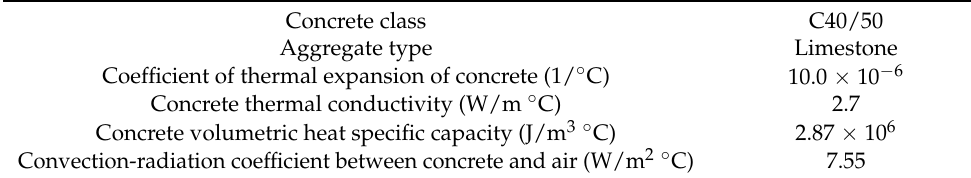
Table 3. Thermo-mechanical parameters used in the FE